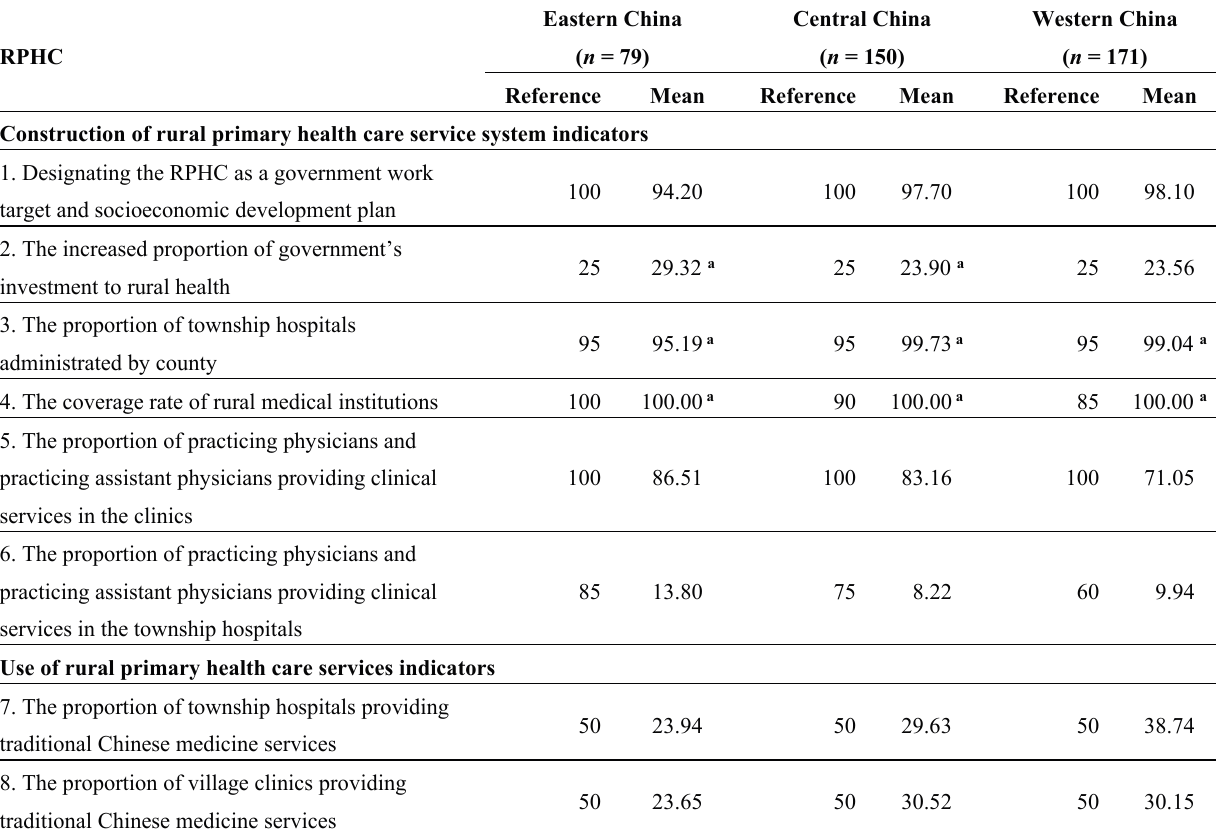
Table 3. Indicators for 400 sample counties in Eastern, Central and Western China’s RPHC compared with reference values